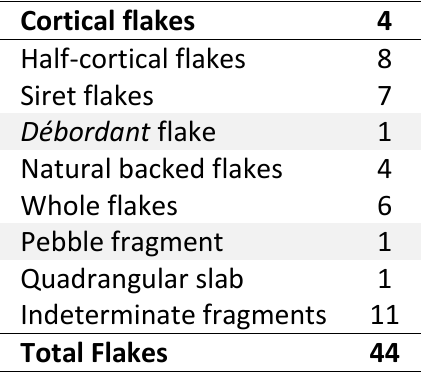
Figure 15. Core on slab. Table 5. Number and type of